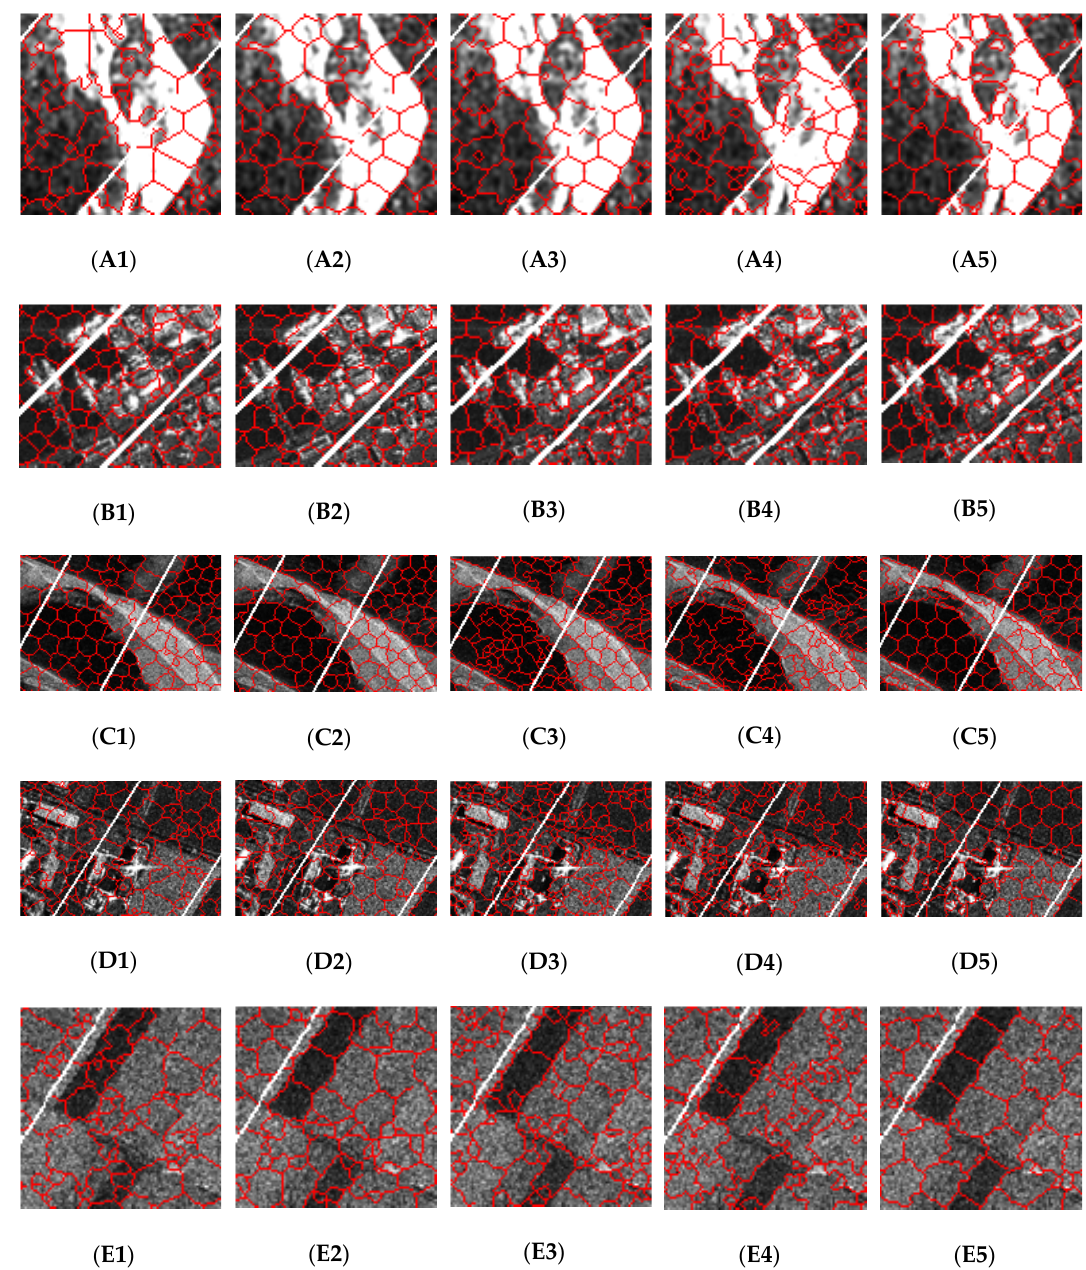
Figure 21. Resulting superpixels of image patches A, B, C, D, and E from the first row to the last row, respectively. The results shown from the first column to the last column are generated by SLIC, PILS, LBSLIC, PBSLIC, and PSDSD, respectively.